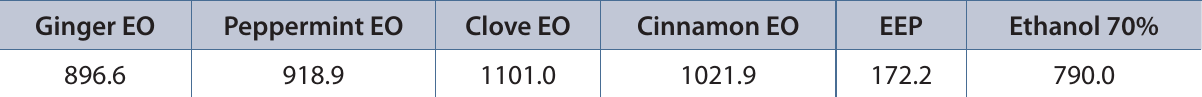
Table 1. Density values (mg x mL –1 ) of essential oils (EO) and 70% ethanol and EEP (ethanolic extract of propolis) dry weigh (mg x mL –1 )